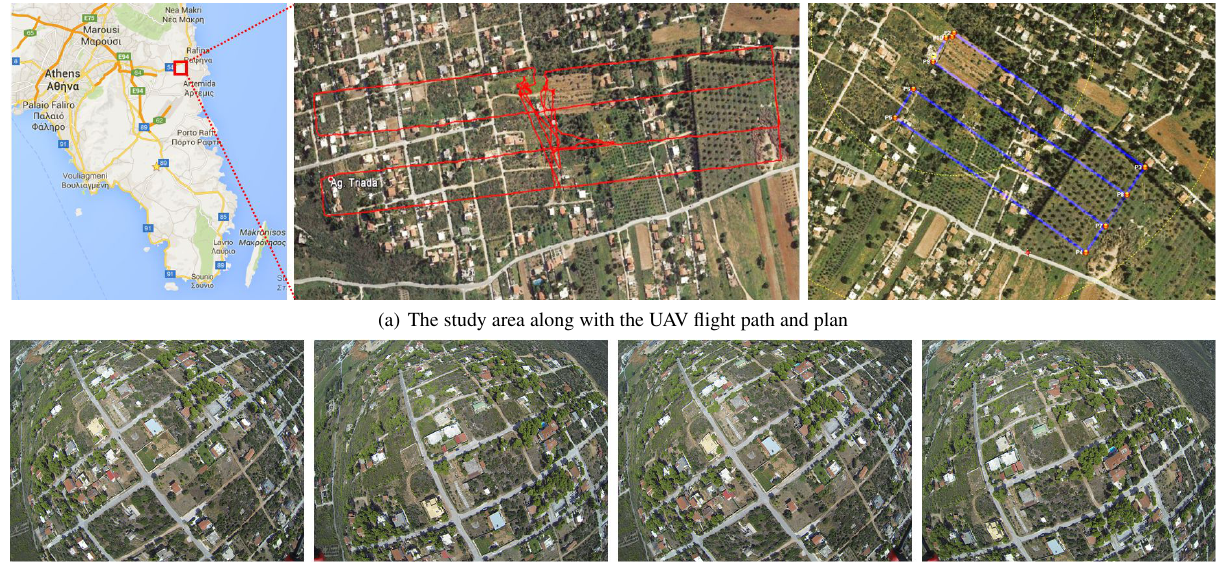
Figure 1: The study area covers a 0.8 Km 2 region in the Eastern Perfecture of Attica, Greece. Two autonomous flights were performed and more than 300 RGB images with important geometric distortions were collected.